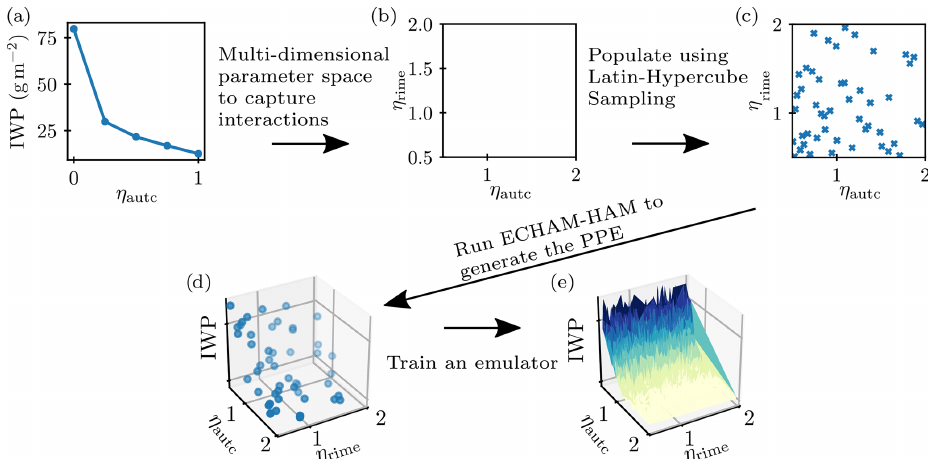
Figure 3. Sketch of the employed methodology: we move from (a) one-dimensional sensitivity studies wherein one process is perturbed by varying the parameter η (Sect. 3.1) to (b) a multidimensional parameter space. (c) The input parameter space is filled with Latin hypercube sampling and supplied as input to ECHAM-HAM. The simulations form the perturbed parameter ensemble (PPE). The (d) PPE output is (e) fitted using a Gaussian process emulator for each variable of interest to generate a smooth response surface, upon which sensitivity analysis can be applied. Note that this is an illustrative sketch of the method for a PPE with two input dimensions, whereas our PPE has four dimensions, and that the data used to generate it are only illustrative as well. The shading in (d) illustrates depth